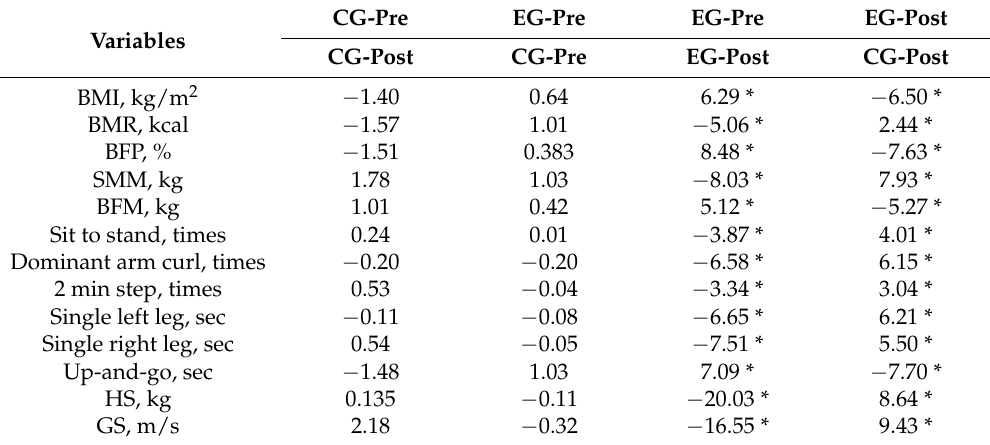
Table 5. T -test of the body composition results of the EG and CG as well as for the SFT, HS, and GS pre- and